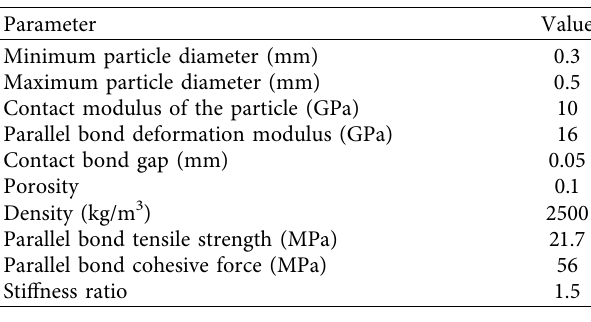
Figure 2: Schemes of rock models with a set of cross-joints with different (a) joint cross-angles and (b) joint lengths. Table 1: Meso-parameters for the PBM [14].